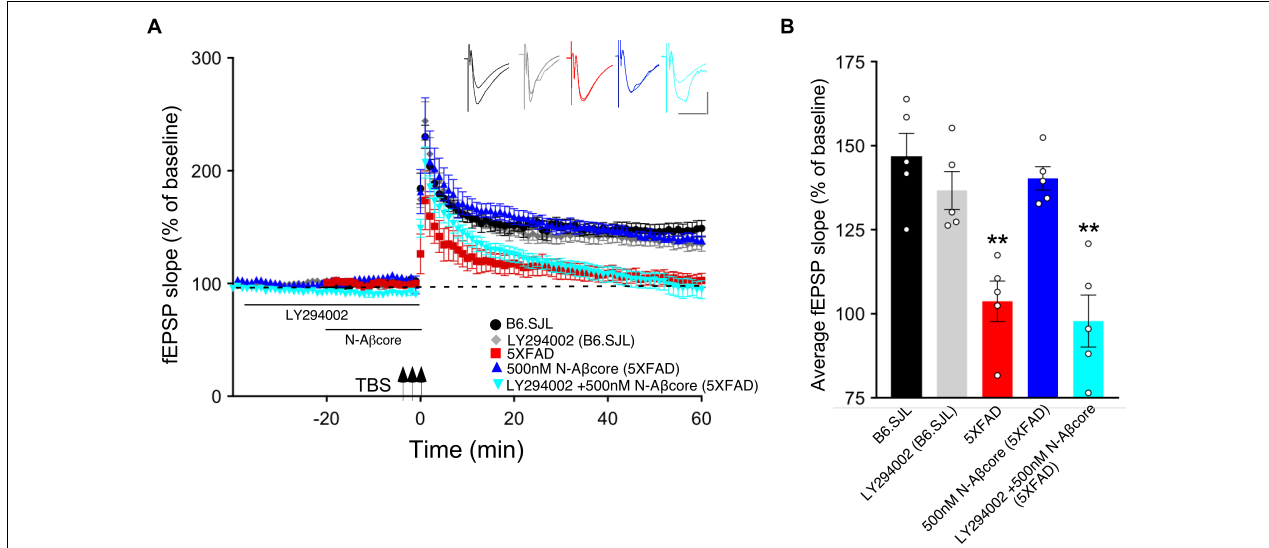
FIGURE 3 | N-A β core protection of A β -induced synaptic dysfunction involves the PI3 kinase pathway. (A) TBS-induced LTP for B6.SJL slices perfused with control aCSF (black) or 100 µ M LY294002 (gray) and for 5xFAD slices with aCSF (red), 500 nM N-A β core (blue) or 500 nM N-A β core plus 100 µ M LY294002 (cyan). Color-coded inserts showing examples of fEPSPs (baseline vs. LTP). (B) Quantification of average fEPSP slope values for 50–60 min post-TBS (one-way ANOVA: F ( 4 , 20 ) = 13.63, p < 0.0001). Bonferroni post hoc tests showed that rescue of the LTP deficit in the 500 nM N-A β core-treated 5xFAD slices (** p = 0.004, 500 nM N-A β core 5xFAD vs. 5xFAD; p < 0.05, vs. aCSF B6.SJL) was blocked by 100 µ M LY294002 pretreatment (** p = 0.0002, 100 µ M LY294002 + 500 nM N-A β core vs. aCSF B6.SJL). Arrows indicate timing of TBS in (A) . All data are expressed as means ± SEM. N = 4 for each condition (1 slice/mouse). Inset calibration: horizontal, 10 ms; vertical, 0.4 mV. ** p <